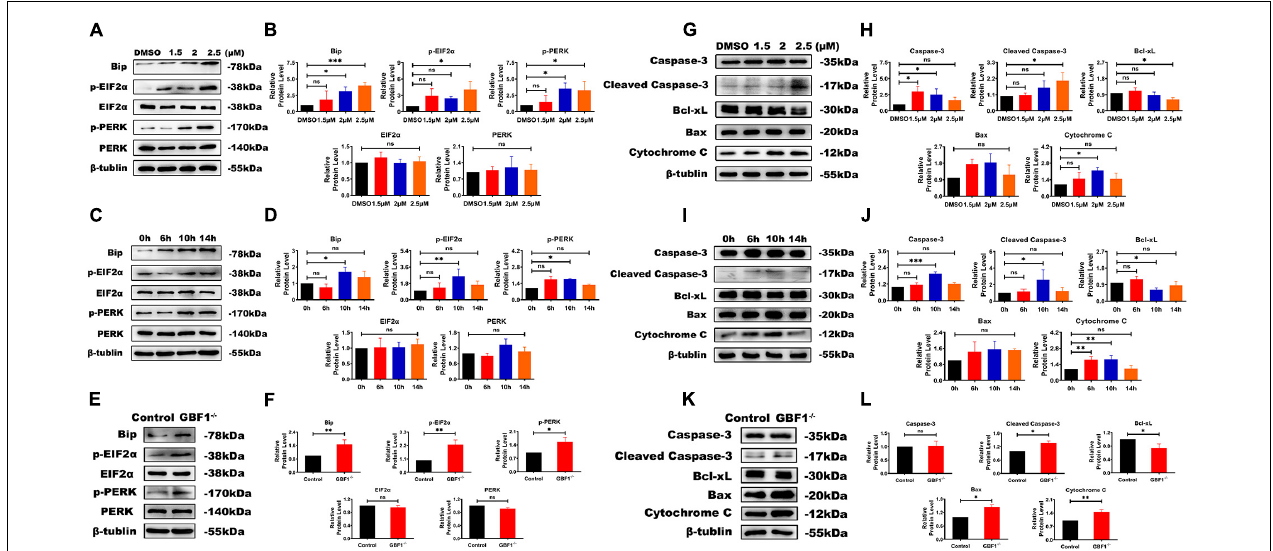
FIGURE 4 | Interference with GBF1 induced osteoclast ERS and autophagy. (A–D) Western blot analysis of autophagy-related protein in RANKL-induced osteoclasts after GCA treatment (0, 1.5, 2, and 2.5 µ M) and at different time points (0, 6, 10, and 14 h) treated with 2 µ M GCA. (E,F,K,L) Western blot analysis of autophagy-related protein in RANKL-induced osteoclasts by siRNA transfection. (E,F) Western blot analysis of autophagy related proteins in RANKL induced osteoclasts by siRNA transfection. (G–J) Western blot analysis of apotosis related proteins induced by GCA. (K,L) Western blot analysis of apotosis related proteins after knocking down of GBF1. ∗ p < 0.05; ∗∗ p < 0.01; ∗∗∗ p < 0.001.